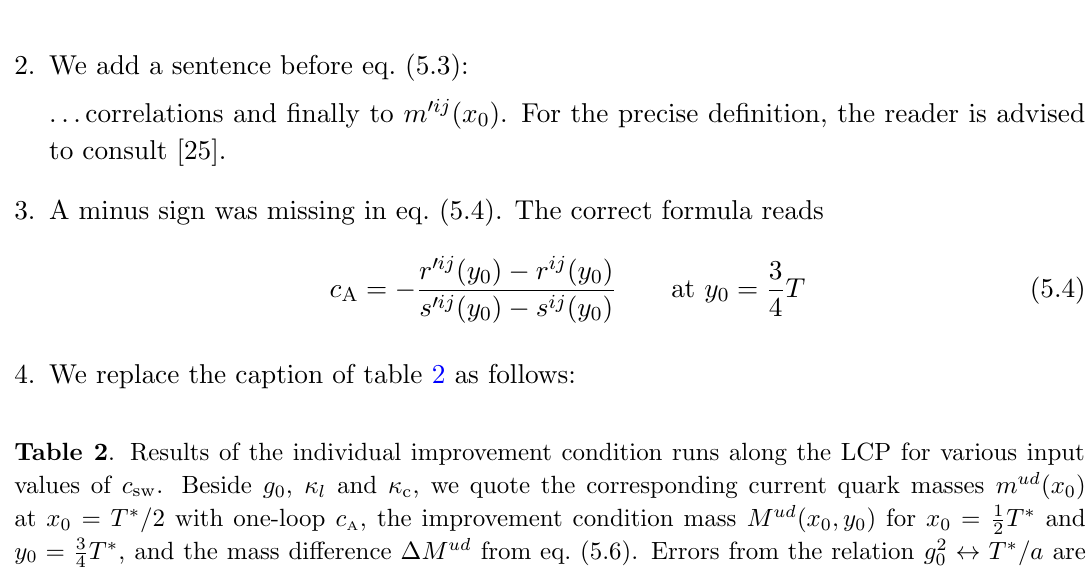
T (cid:3) and 2 $ T (cid:3) =a are 0